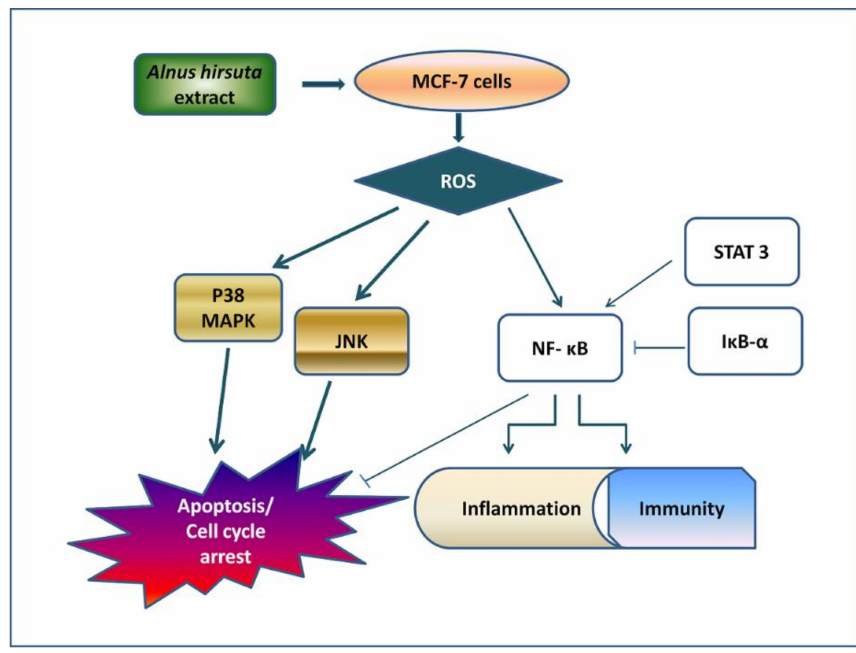
Figure 9. Schematic illustration of the potential regulatory pathway of the AHC extract against MCF-7